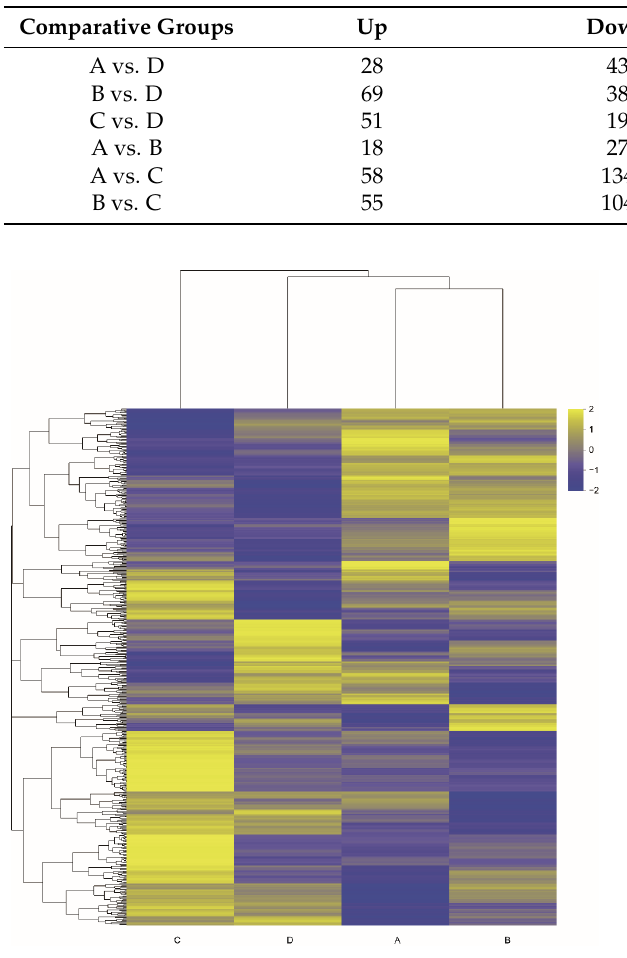
Figure 5. Heatmaps based on differentially expressed genes from six pairwise comparisons of four groups. A: the noisy-calls playback group, B: the tonal-calls playback group, C: the white-noise playback group, and D: the control group.